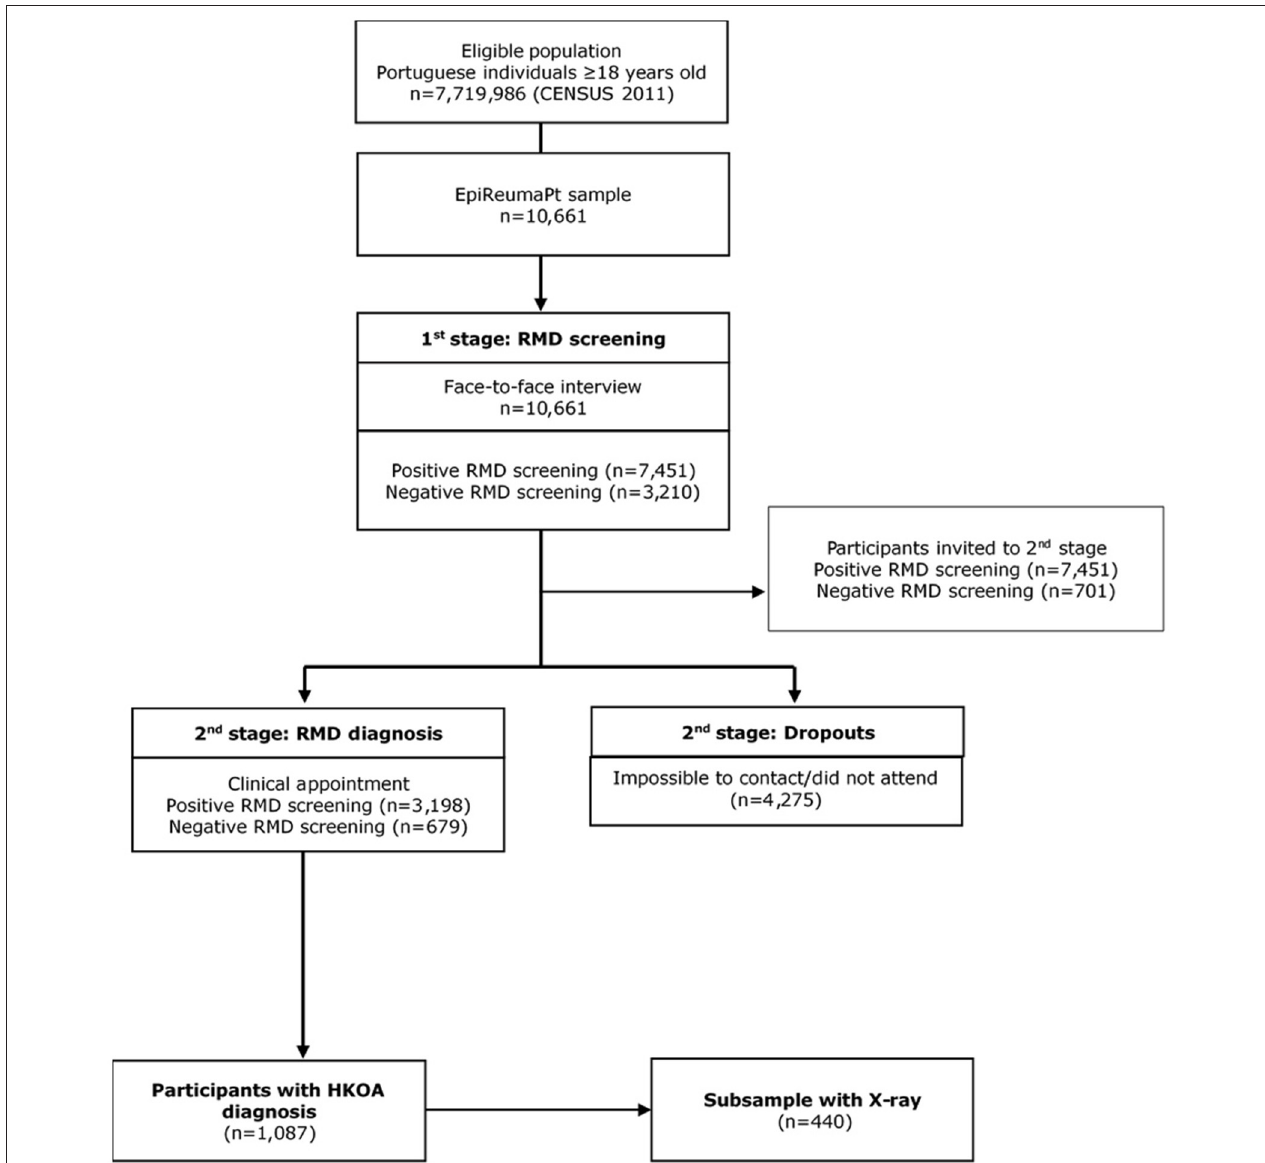
FIGURE 1 | EpiReumaPt study